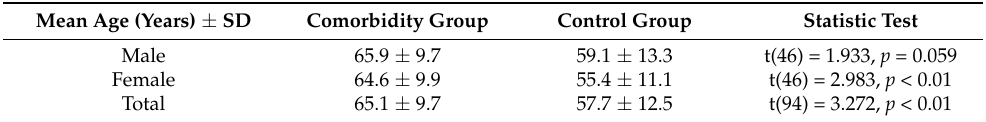
Table 1. Mean age by gender of patients suffering from Bell’s palsy for the comorbidity and con- trol group.